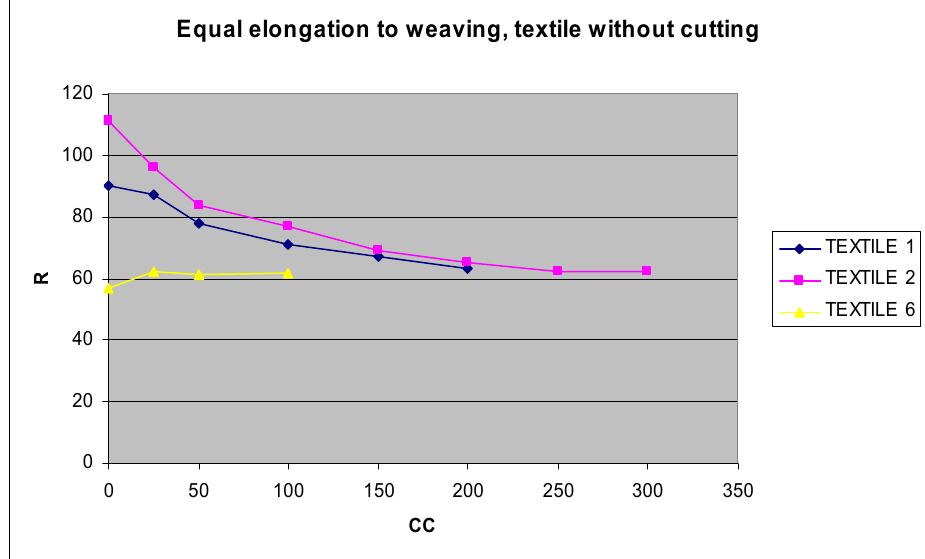
Figure 7. Graphic of the fourth test